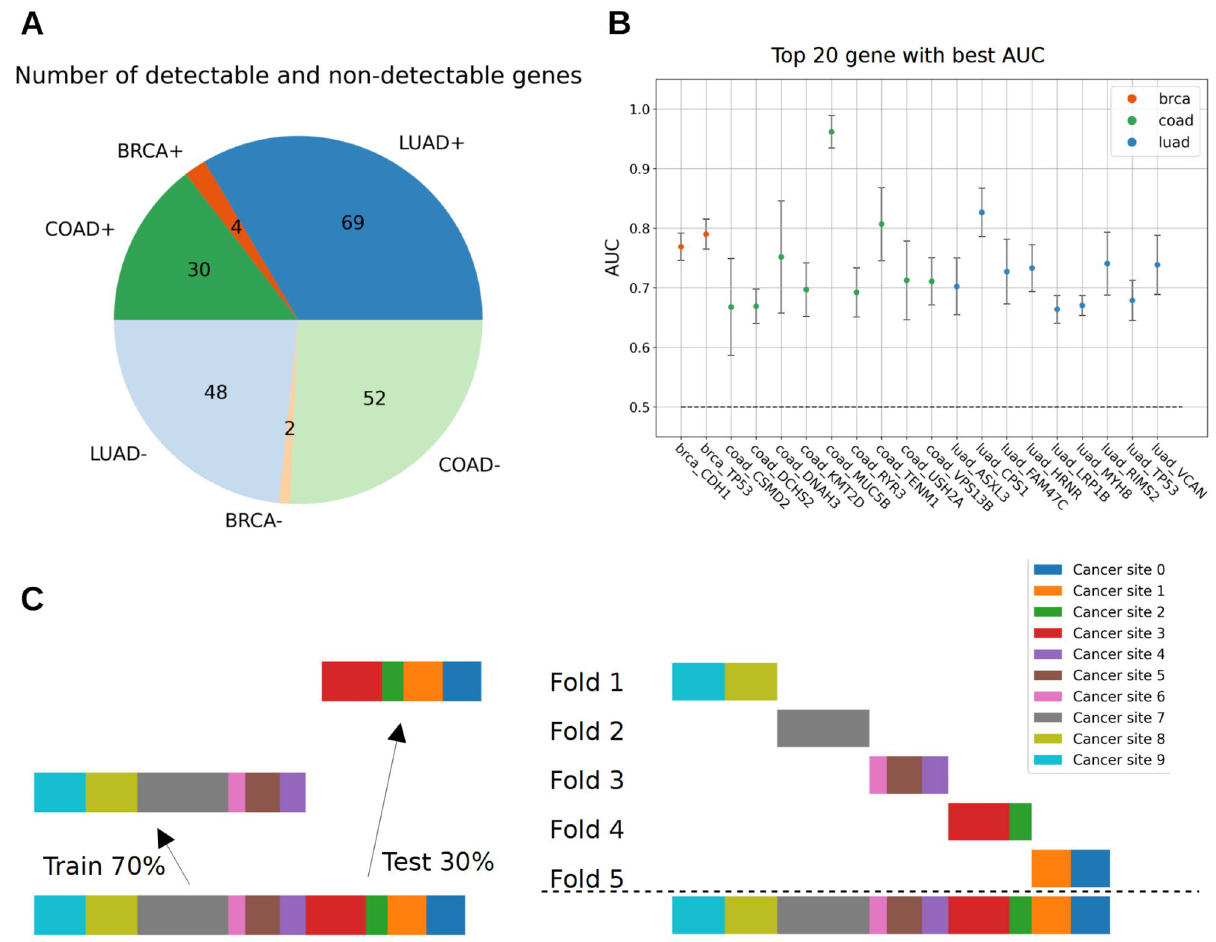
Figure 1. Description of predictable genes in TCGA-LUAD, TCGA-COAD and TCGA-BRCA. ( A ) Pie of the number of genes according to their dataset and their predictability (see Material and Methods). Predictable genes are shown in dark color with “+”, other genes are shown in light color with “-”. Statistical significance was determined by a Student t test corrected with Benjamini–Hochberg for multiple hypothesis testing (see Methods for further details). The displayed number is the number of genes within each category of the pie. ( B ) Scatter plot of the AUC of predictable genes, only the 20 genes with top AUC were selected for clarity. Error bars are the standard deviation of the AUC over 5 repetitions with random initialization. The dashed bar at 0.5 corresponds to the theoretical AUC of a random classifier. Dataset of origin is shown in color with the same color code as in the figure slot A. ( C ) Description of the train-test split for gene prediction on the left and the fivefold split for metric estimation on the right. The split ensures that there is no overlap of cancer sites between train and test in order to avoid biases due to batch effect. The 10 cancer sites are shown to illustrate the general idea but do not represent the true cancer